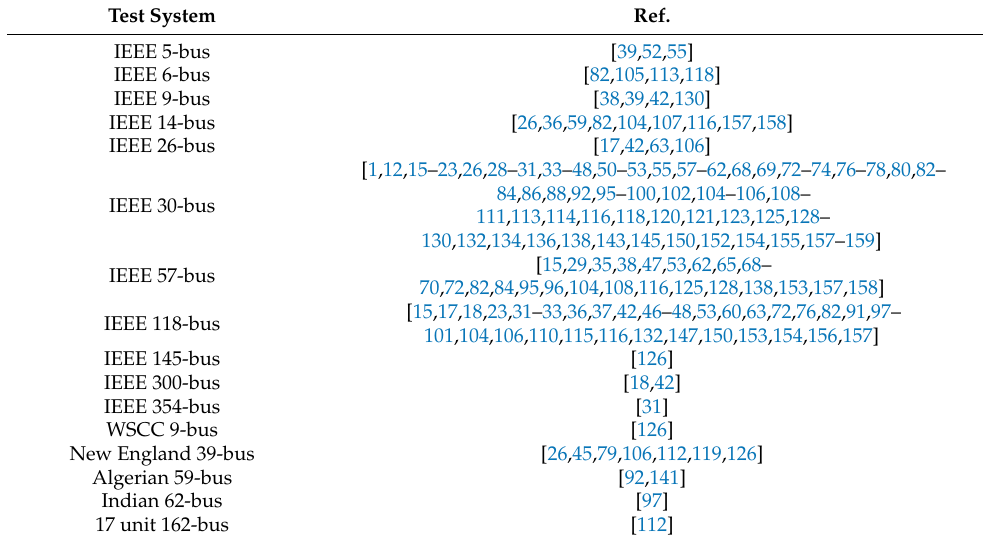
Table 4. Classification of references based on test systems. Test